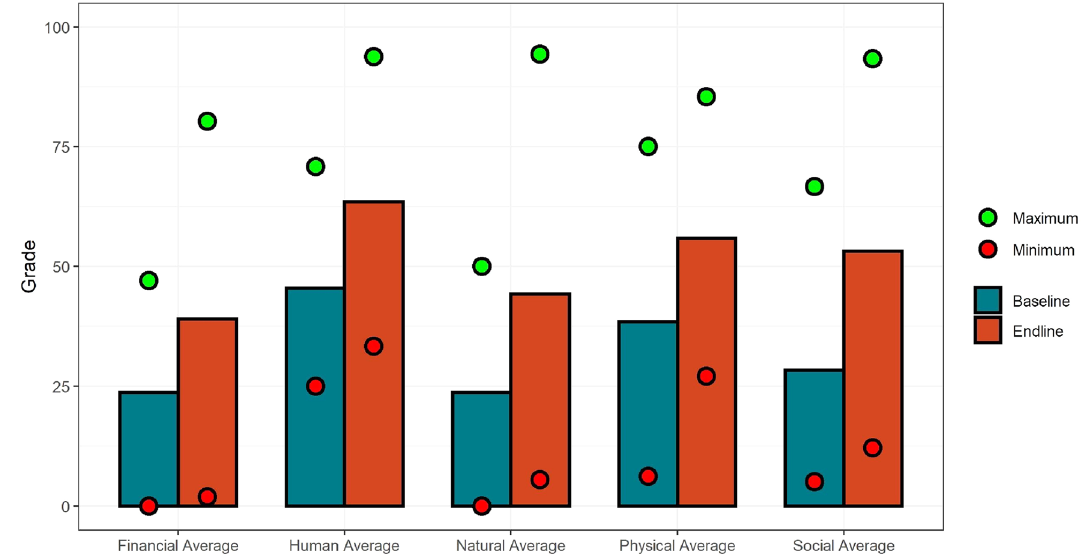
Figure 2. Comparing BL and EL average grades for the five